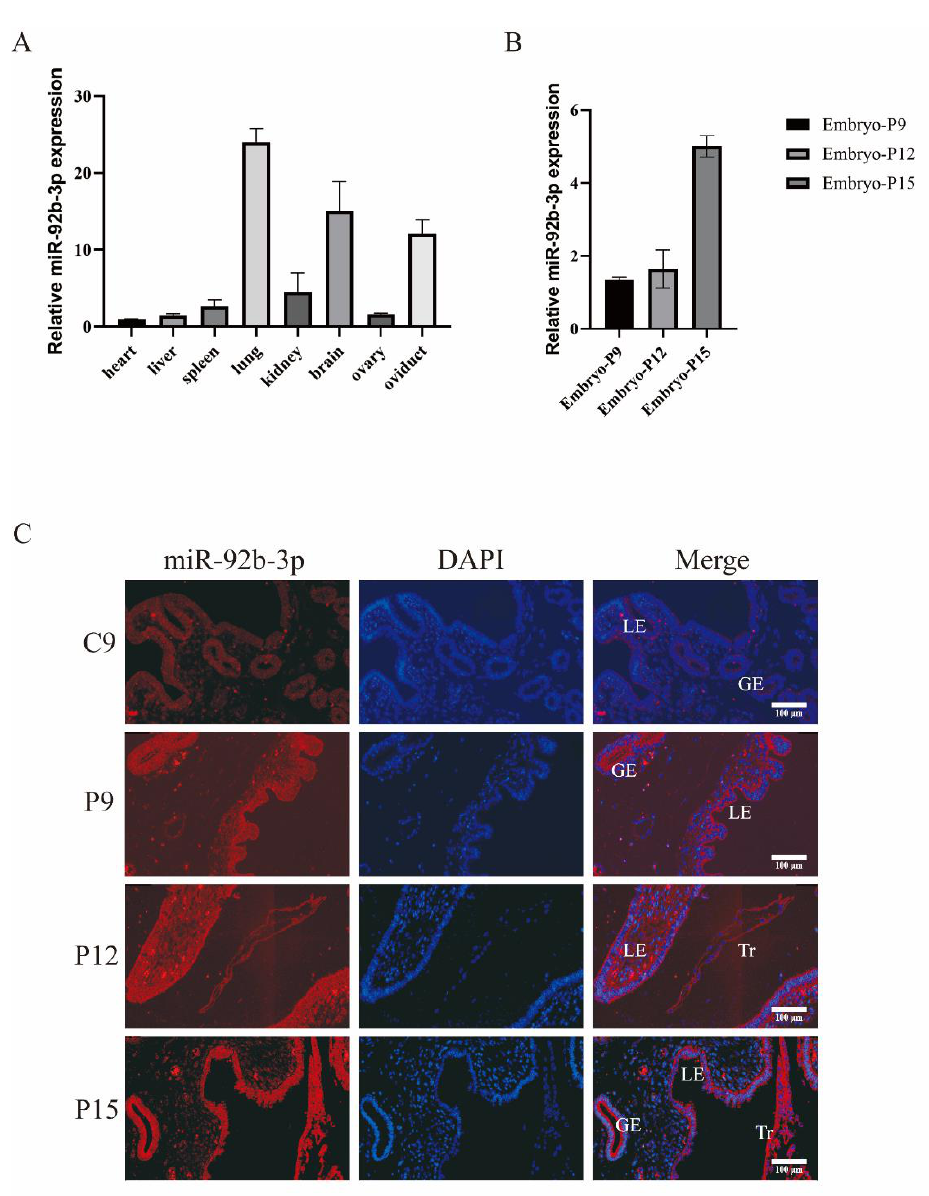
Figure 1. The expression profile of ssc-miR-92b-3p. ( A ) Real-time fluorescence quantification of miR-92b-3p expression in different pig tissues. ( B ) miR-92b-3p expression gradually increased in embryonic tissue on days 9, 12, and 15 of pregnancy (P9, 12, and 15). ( C ) miR-92b-3p (red fluorescence) expression gradually increased in endometrial tissue on day 9 of the estrus cycle (C9), and in embryonic tissue on days 9, 12, and 15 of pregnancy (P9, 12, and 15). GE: glandular epithelial tissue, LE: luminal epithelial tissue, and Tr: Trophoblast Cell. Scale bar 100μm.